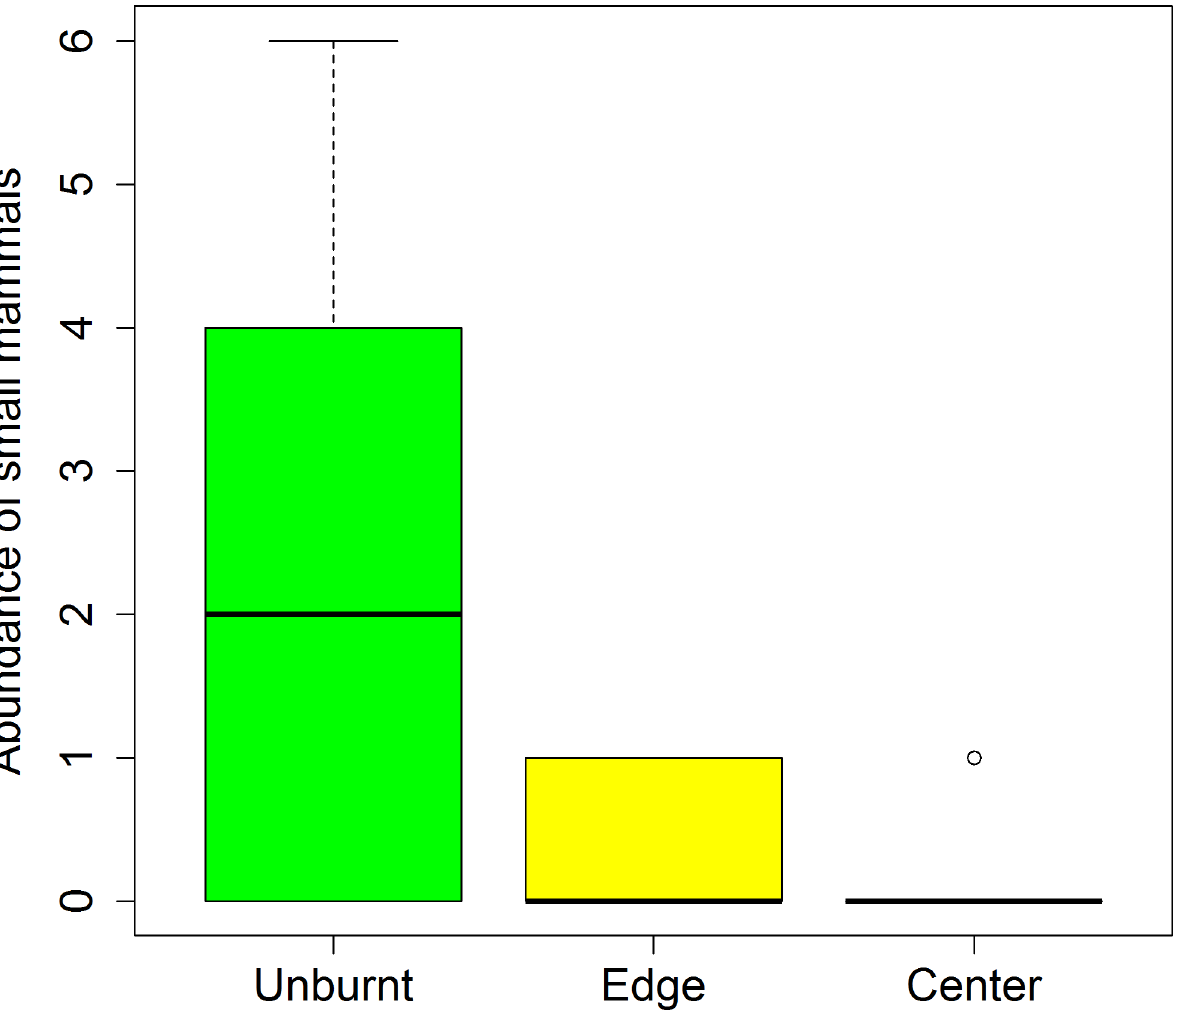
Fig 4. Abundance of small mammals postfire. Mammals collected in pitfall traps during two years (2013, 2014) in Cortes and Andilla, and in three different zones (unburnt, burnt edge and burnt centre). The sampling effort was twice in the center (n = 12 plots) that in the edge (n = 6 plots) and unburnt (n = 6